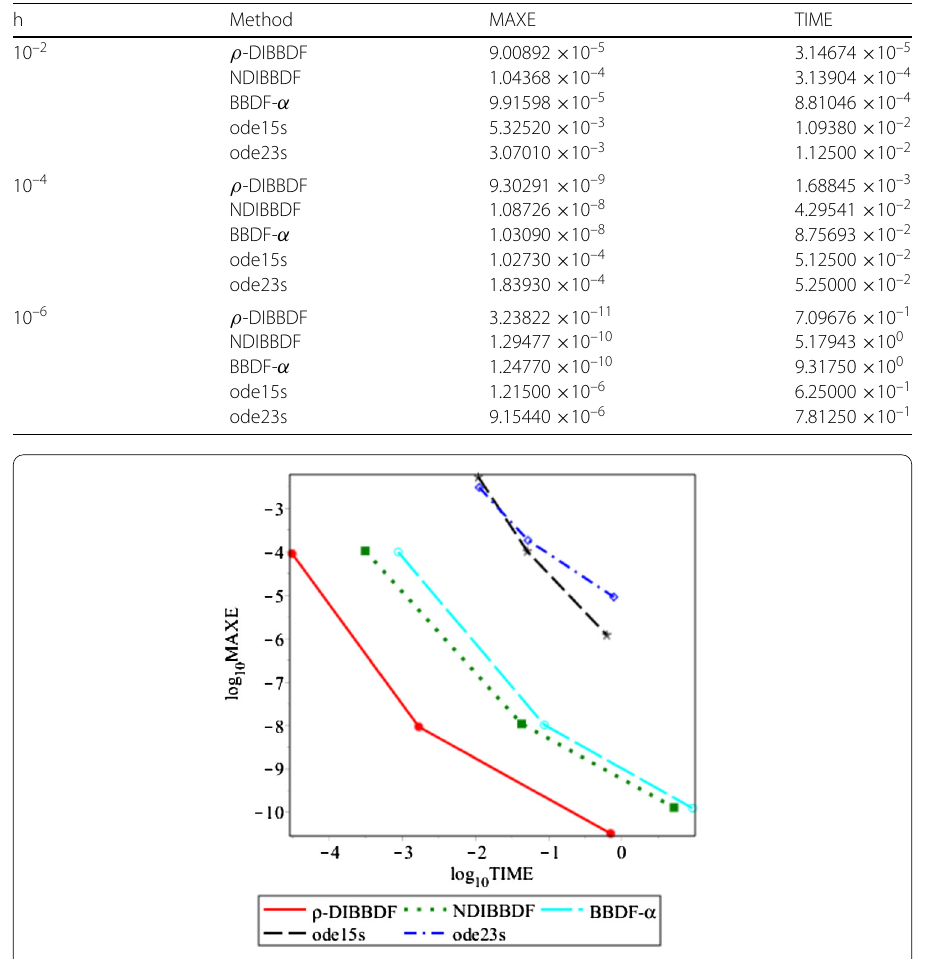
Figure 8 Graph for log 10 MAXE against log 10 TIME of Model